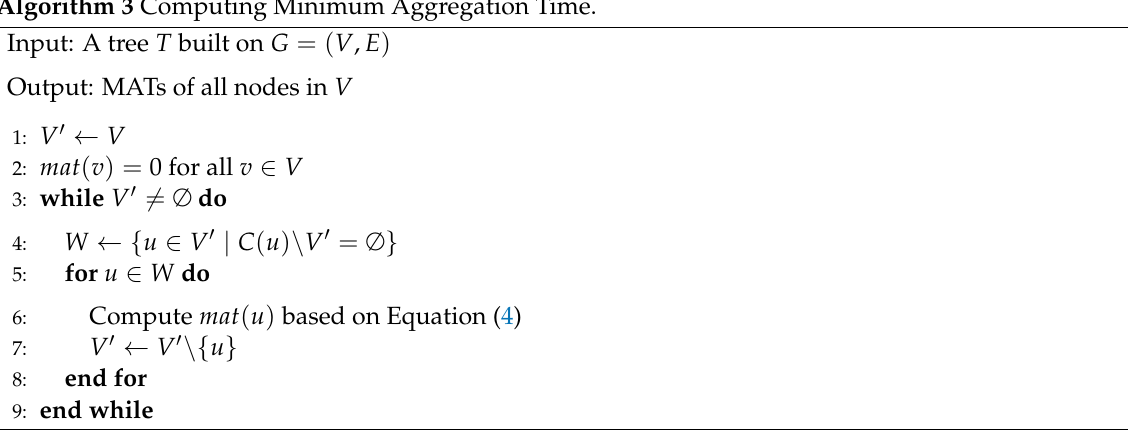
Algorithm 3 Computing Minimum Aggregation Time.